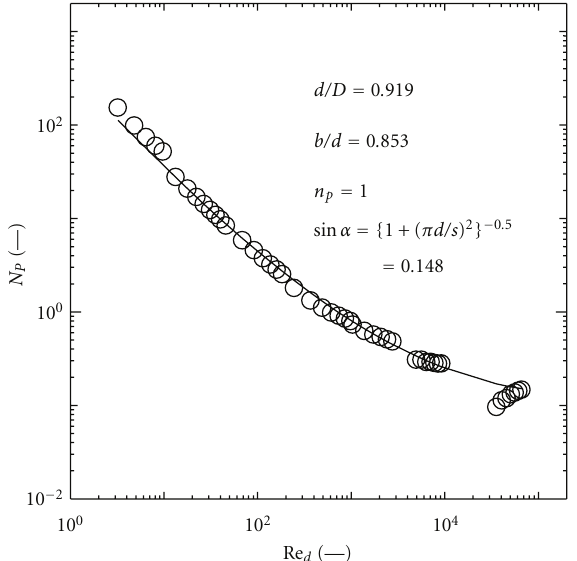
based on the correlation of Kamei and Hiraoka, were de- veloped for several kinds of mixing impellers, and it was shown that the calculated values of the power number agreed very closely with the measured ones. In future work, this cor- relation will be expanded to other